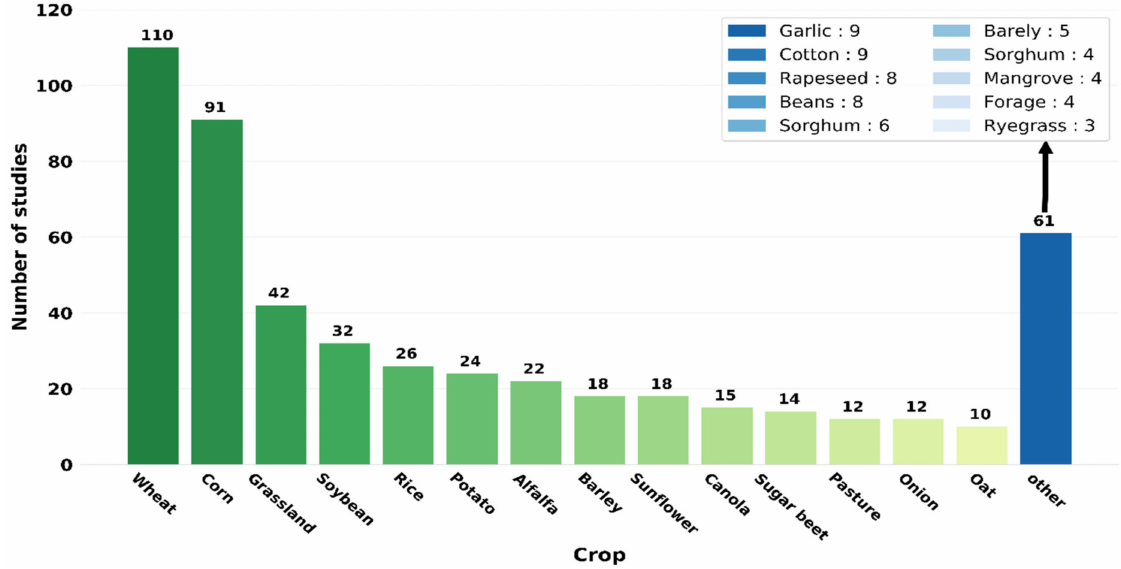
Figure 6. The number of manuscripts studying different crop